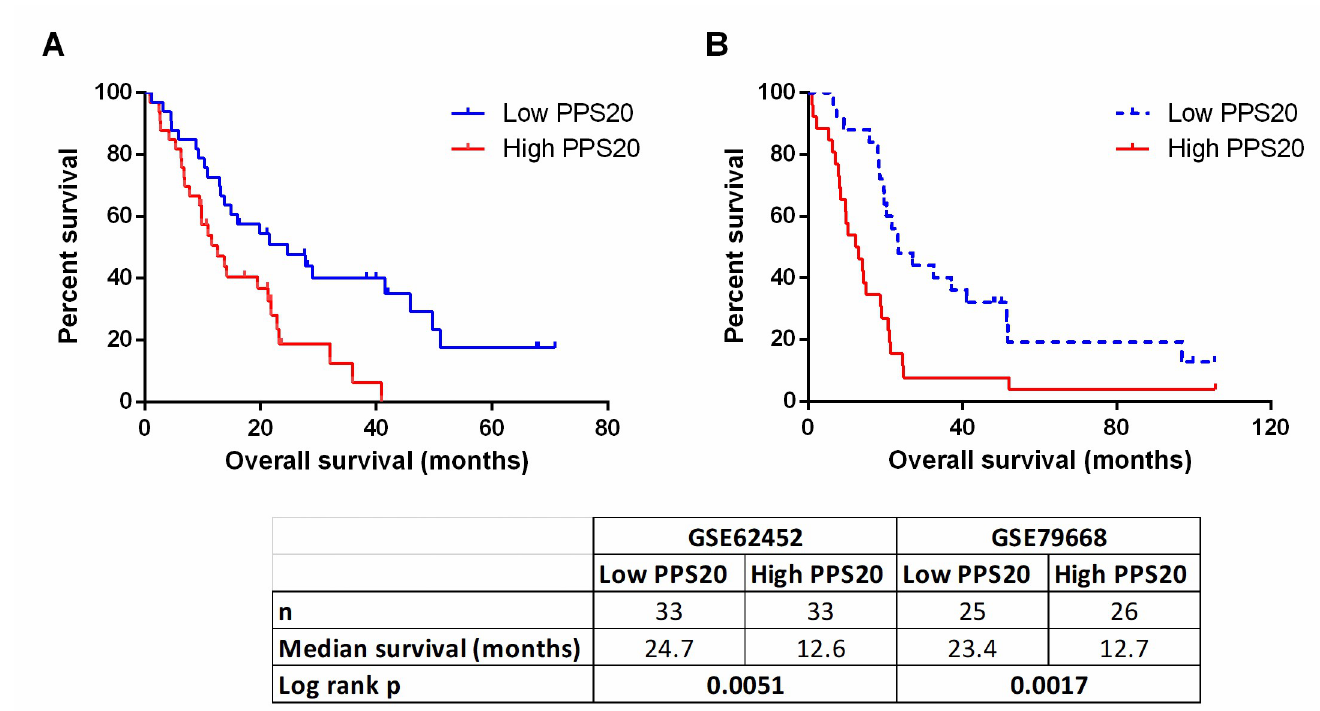
Fig 2. Prognostic stratification by PPS20 in validation cohorts. Kaplan Meier graphs based on PPS20 for GSE62452 (A), GSE79668 (B). Cut-off for the score is median in all cohorts. Statistics are given below the figure.